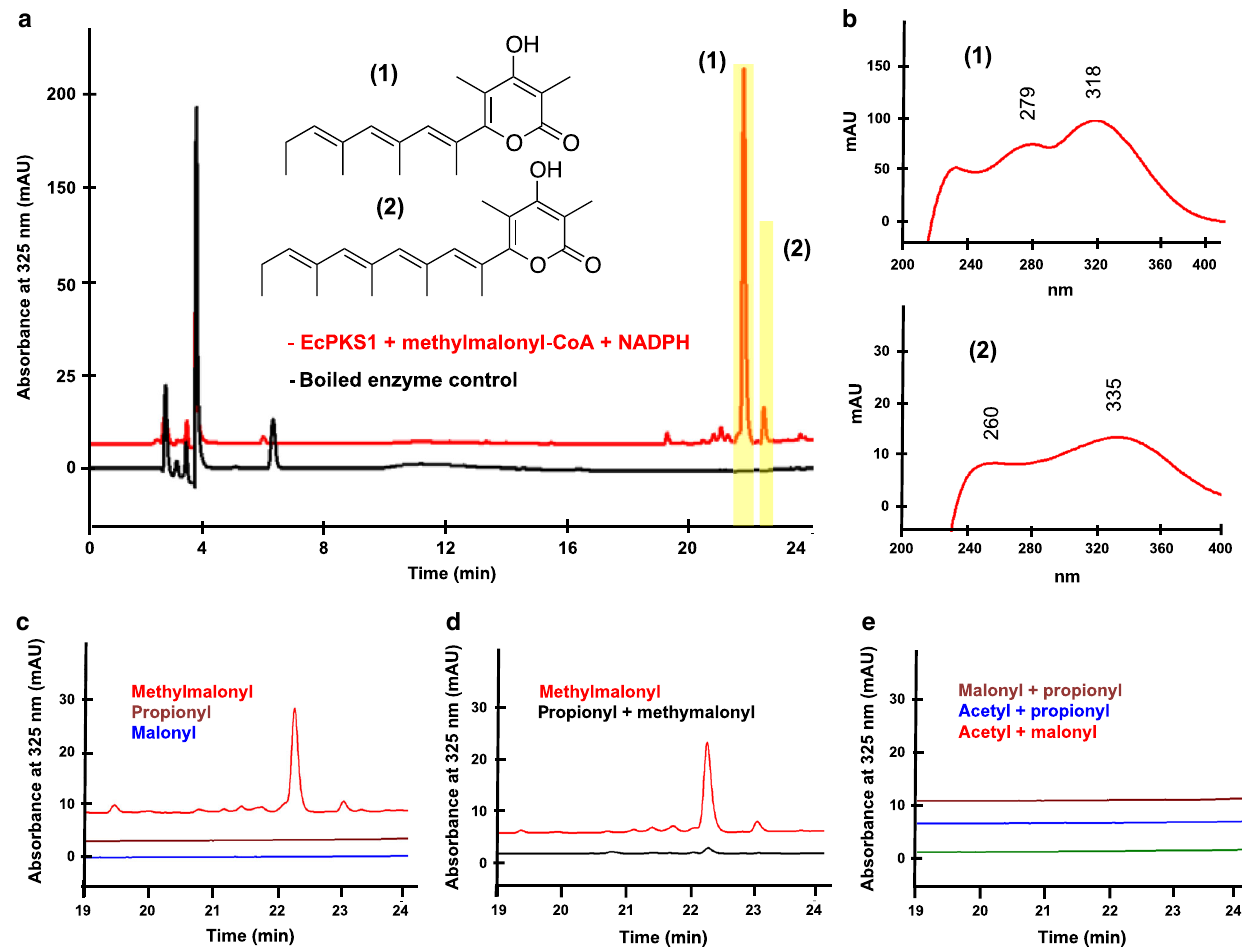
Fig. 3 EcPKS1 synthesizes the tridachione precursor. a Incubation of EcPKS1 with methylmalonyl-CoA and NADPH resulted in the synthesis of polyene 1 and tridachione precursor 2 . b UV spectra of the synthesized products showing features of polyene propionates consistent with the structural